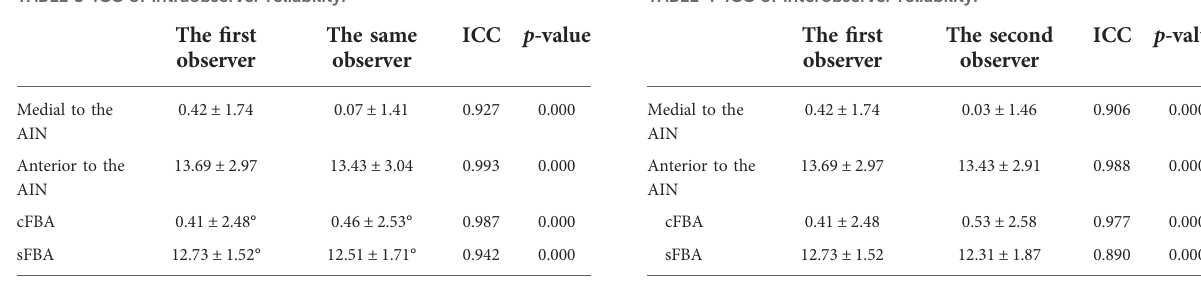
TABLE 3 ICC of intraobserver reliability. TABLE 4 ICC of interobserver